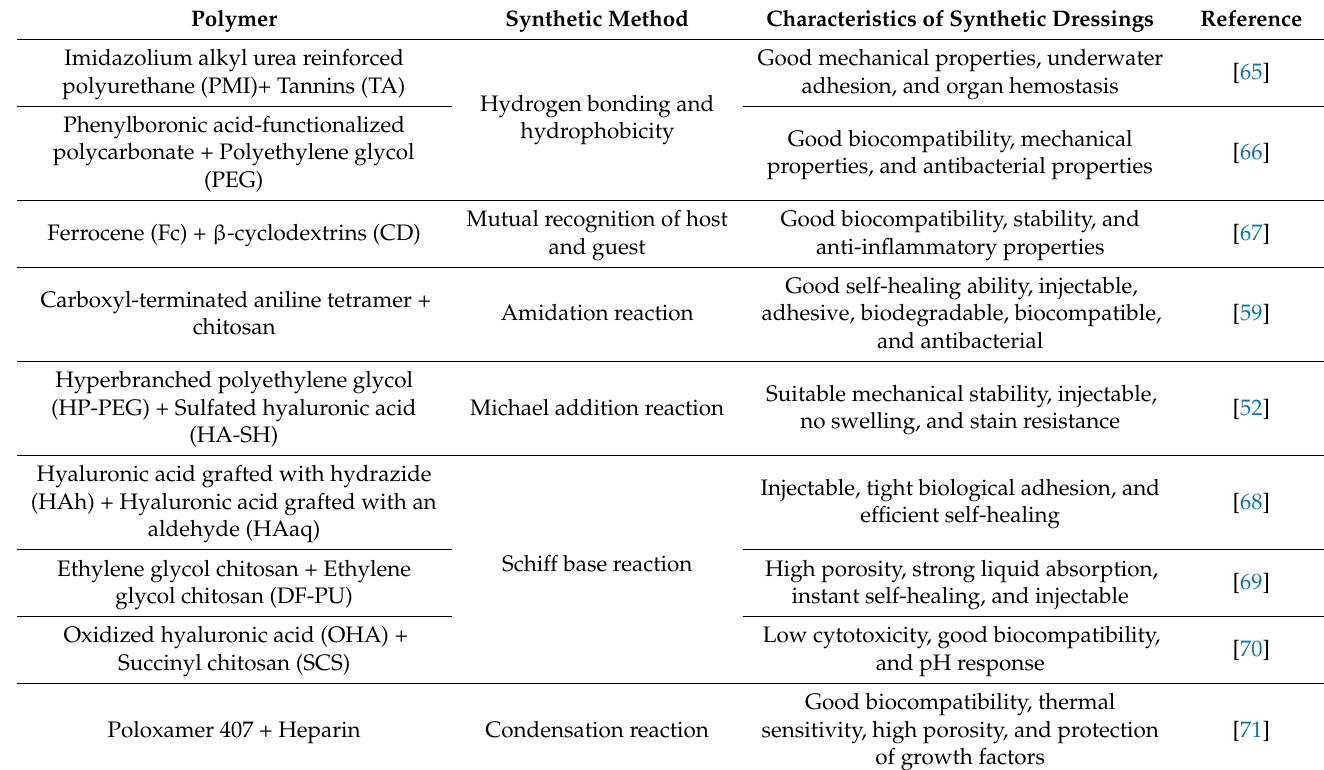
Table 2. Synthesis method and characteristics